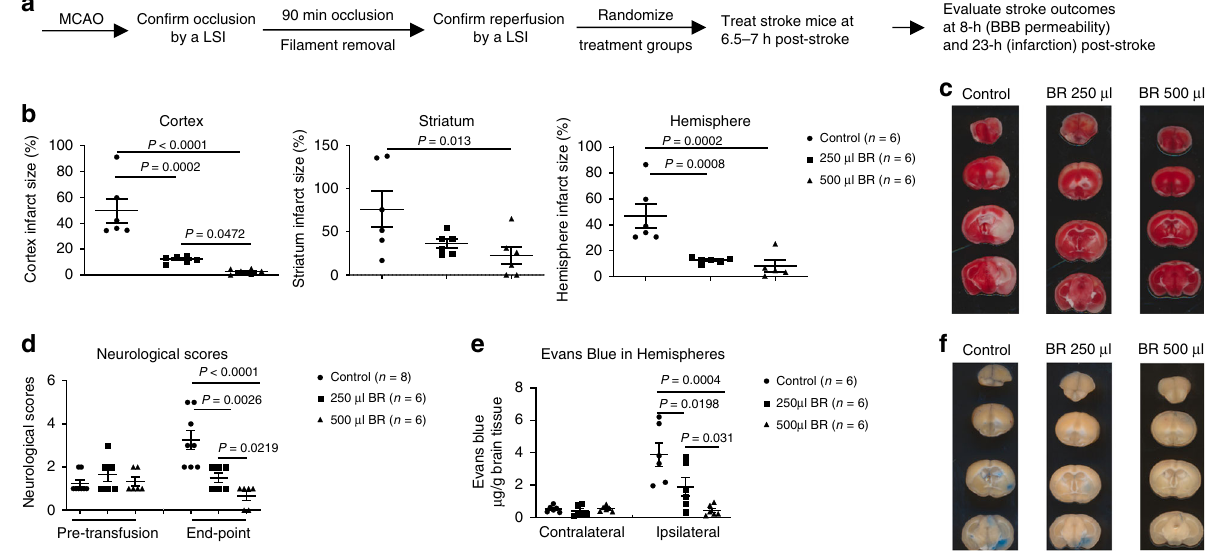
Fig. 1 Blood replacement improves stroke outcomes. a Experimental design. Mice (8~12 months old males) underwent tMCAO for 90 min. The occlusion and reperfusion were con fi rmed by a laser speckle imager (LSI). Mice were randomized into three groups: sham control, 250 µ l, or 500 µ l of blood from healthy donors (3~6 months old). Blood was transfused into stroke mice at 6.5~7 h post stroke. The same volume of blood was withdrawn from the recipient stroke mice during blood transfusion. Brain infarct volumes were measured at 23 h after ischemia induction. BBB permeability was evaluated at 1 h post blood replacement (BR). b BR reduced infarct volume in the cortex, striatum, and total hemisphere dose dependently. Sham control (circles, n = 6), 250 µ l group (squares, n = 6), or 500 µ l group (triangles, n = 6) of blood from healthy donors. c Representative triphenyltetrazolium chloride (TTC)- stained coronal brain sections used for infarction analyses. d Neurological de fi cits were signi fi cantly improved in the BR group. Sham control (circles, n = 8), 250 µ l group (squares, n = 6), or 500 µ l group (triangles, n = 6) of blood from healthy donors. e BR reduced Evans blue extravasation in the brain dose dependently. Sham control (circles, n = 6), 250 µ l group (squares, n = 6), or 500 µ l group (triangles, n = 6) of blood from healthy donors. f Representative coronal brain sections showing Evans blue extravasation. Data were presented as means ± SEM. One-way ANOVA followed by post hoc Fisher ’ s unprotected least-signi fi cant difference for multiple comparison tests. Source data are provided as a Source Data fi le.